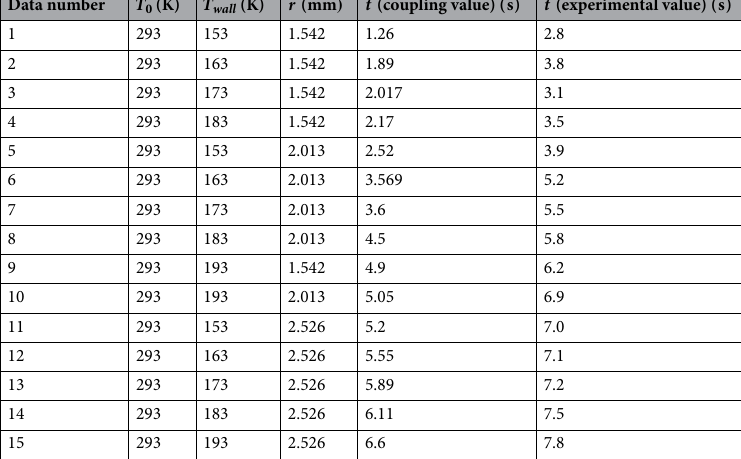
Table 6. Droplet freezing time.